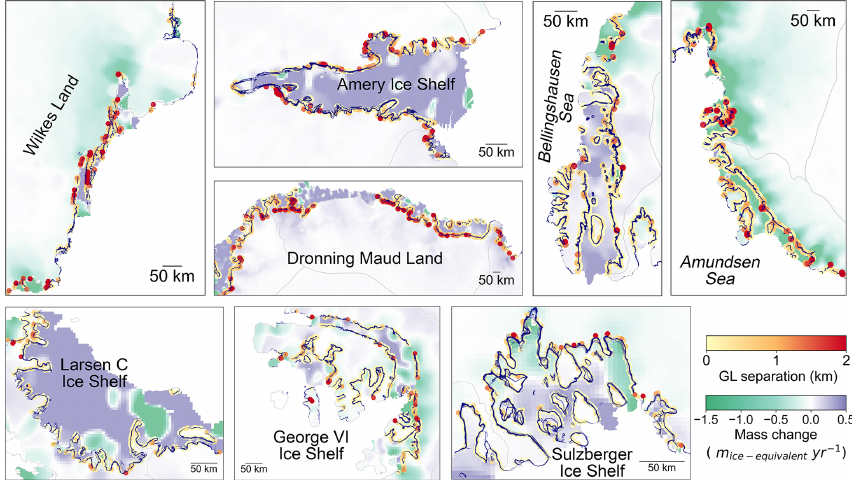
Figure A5. Spatial distributions of the absolute separations between the ICESat-2-derived break in slope (Point I b ) and Sentinel-1a/b DInSAR-derived Point F in 2018 of individual regions in Table 4; the spatial extents of each region are shown as dashed grey boxes in Fig. 11. In all subplots, data are superimposed over the recent mass change map (Smith et al., 2020b); the blue line is the Sentinel-1a/b DInSAR-derived Point F in 2018 (Mohajerani et al., 2021), and the light-grey line is the IMBIE basin boundary (Shepherd et al., 2018; Rignot et al., 2011b).